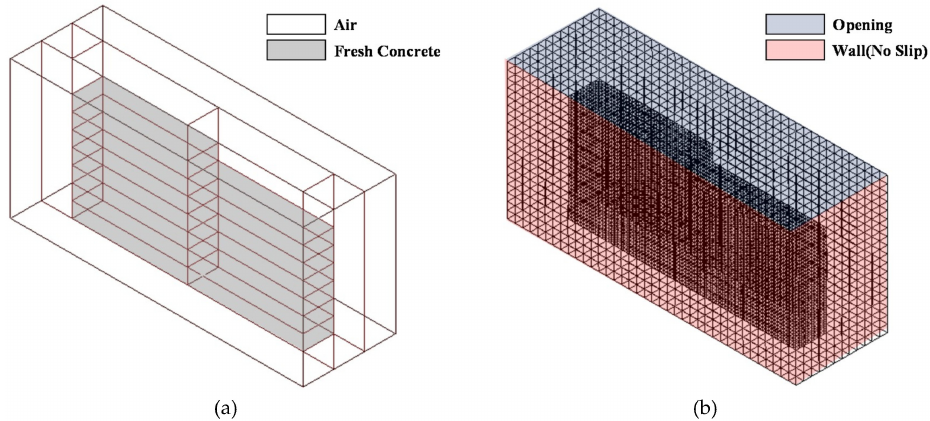
Figure 13. Modelling for CFD analysis. ( a ) Domain of model; ( b ) Mesh and boundary condition.